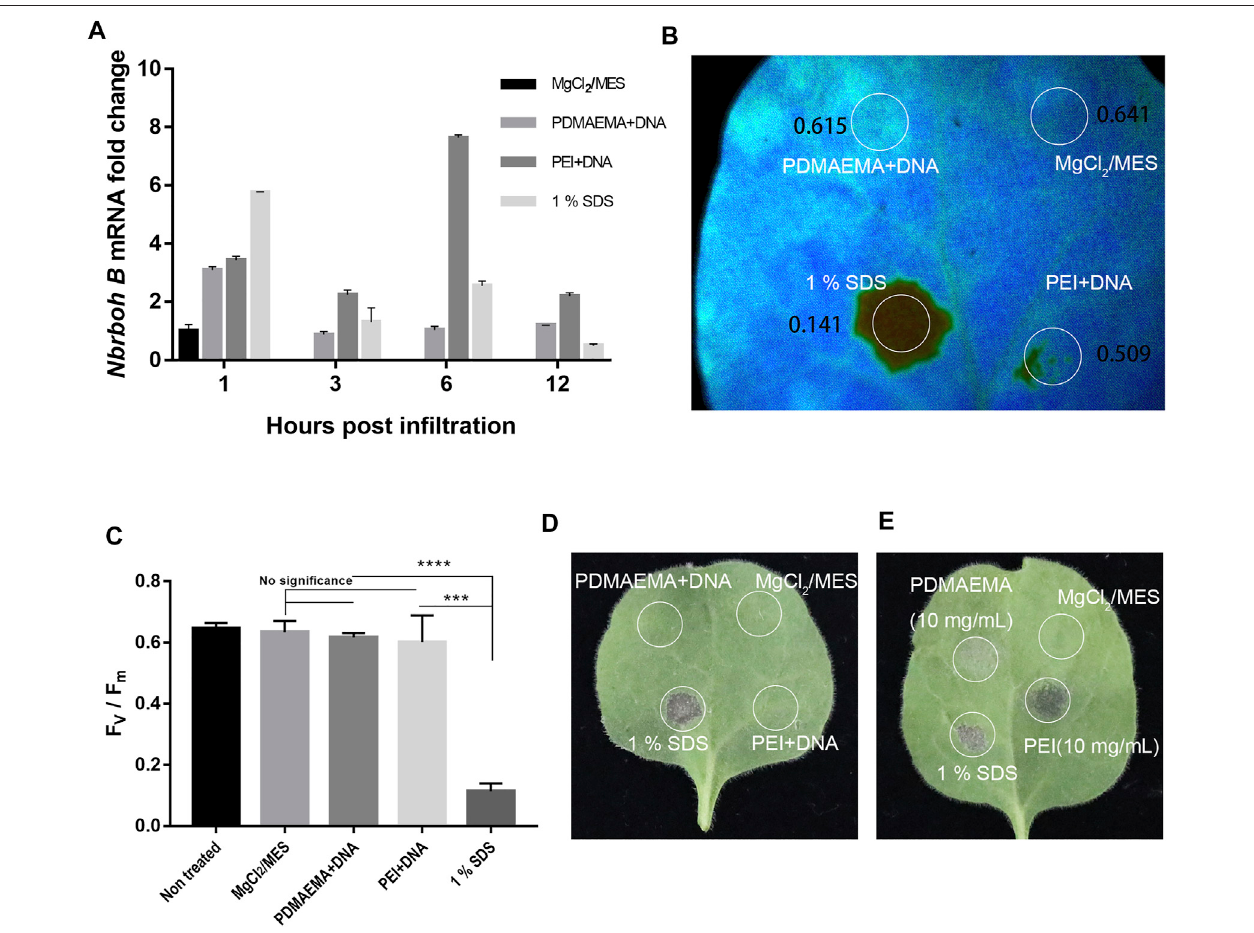
FIGURE6| Toxicityassay. (A) qPCRanalysisof NbrbohB in Nicotianabenthamiana leaveswithdifferentin fi ltrations(MgCl 2 /MES(10 mM)ascontrol,PDMAEMA+ DNA (N/Pratioof15:1),PEI +DNA(N/Pratioof15:1),and1%SDSat atimecourse. (B) PhotosystemIIFv/FmofdifferentlocationstreatedwithPDMAEMA +DNA(N/P ratio of 15:1), PEI + DNA (N/P ratio of 15:1), 1% SDS, and MgCl 2 /MES (10 mM) as control on the same Nicotiana benthamiana leaf. (C) Statistical data of the (B) Fv/Fm ratiorepresentthevariable/maximum fl uorescencemeasurementofthephotosystemIIquantumef fi ciency. (D) Phenotypeofthesingle Nicotianabenthamiana leaf in fi ltrated with MgCl 2 /MES (10 mM), PDMAEMA + DNA (N/P ratio of 15:1), PEI + DNA (N/P ratio of 15:1), and 1% SDS on different positions. (E) Phenotype of a single Nicotiana benthamiana leaf in fi ltrated with MgCl 2 /MES (10 mM), 1% SDS, PDMAEMA (10 mg/mL), and PEI (10 mg/mL) on different